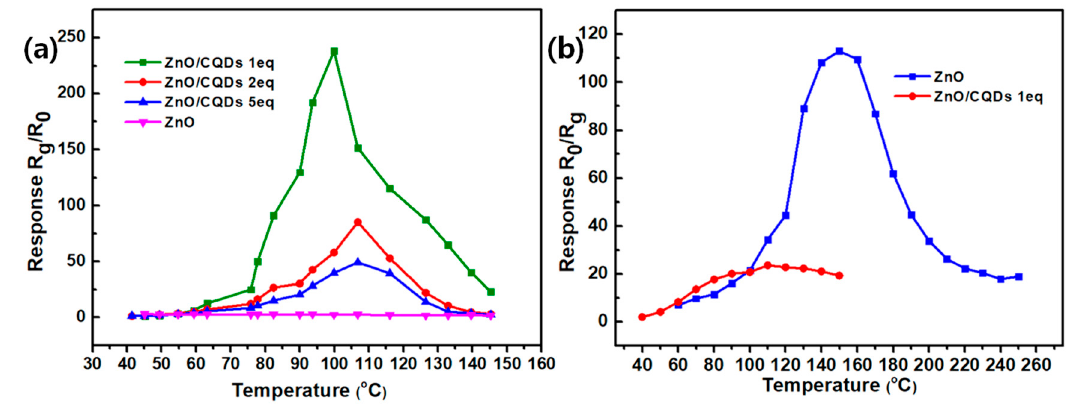
Figure 5. ( a ) Gas-sensing response of ZnO and ZnO/CQDs 1 eq, 2 eq, 5 eq composite at different operating temperatures to 100 ppm NO; ( b ) gas-sensing response of ZnO and ZnO/CQDs 1eq composite at different operating temperatures to 100 ppm H 2 S.